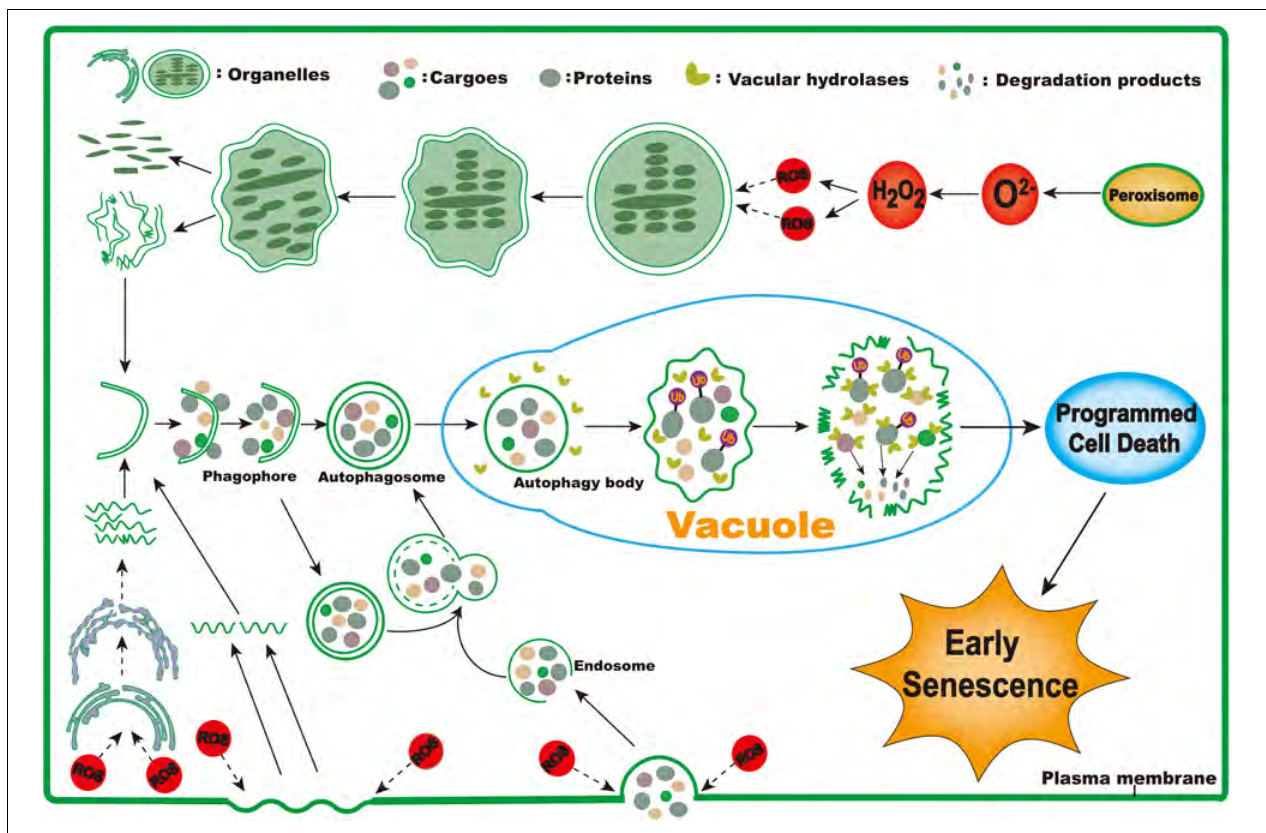
FIGURE 14 | The proposed working model for triggering early senescence in zj-es